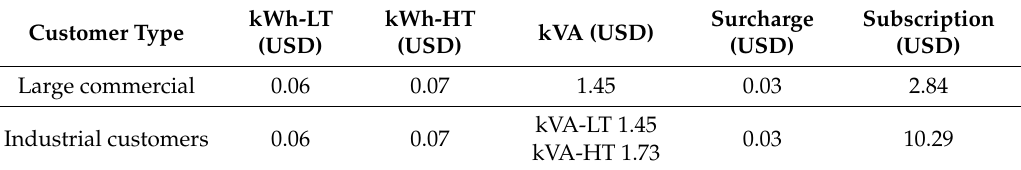
Table 2. Electricity tariffs for commercial and industrial users Data source: N.V. EBS